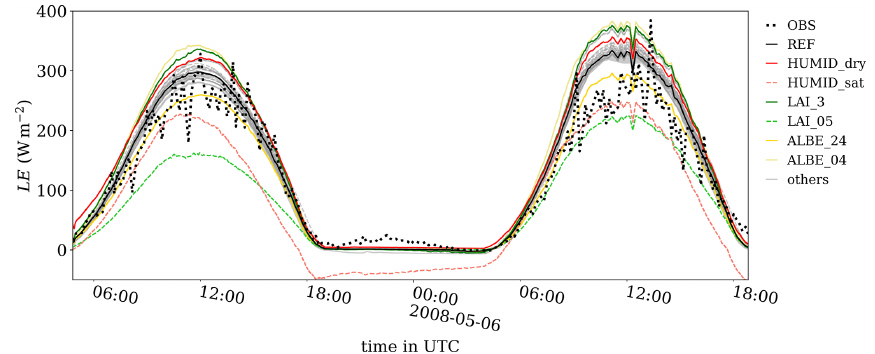
Figure 5. Time series of latent heat flux LE as measured at Cabauw (OBS) and domain-averaged LE for all simulated cases listed in Table 5. Only case REF and some relevant cases are highlighted; all others are shown in gray. The gray transparent area shows minimum and maximum values of the latent heat flux for case REF based on instantaneous hourly horizontal cross sections.